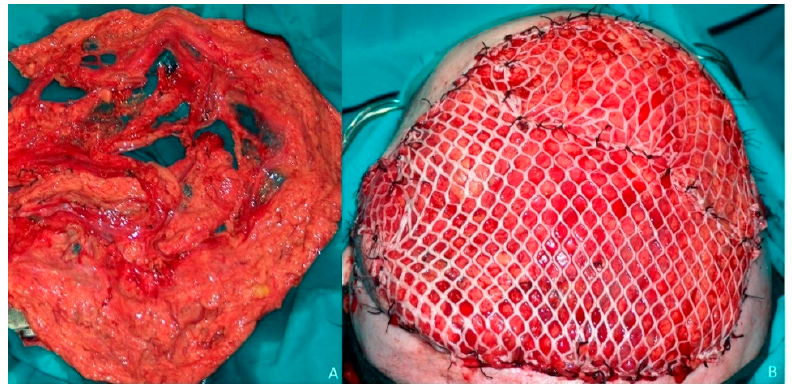
Figure 2. Omental flap. ( A ) Omental free flap harvested through laparoscopic approach pedicled to the right gastroepiploic vessels. ( B ) Scalp defect reconstruction with the omental free flap. Right gastroepiploic vessels anastomosed to the superficial temporal vessels. Omentum covered with a split-thickness skin graft.